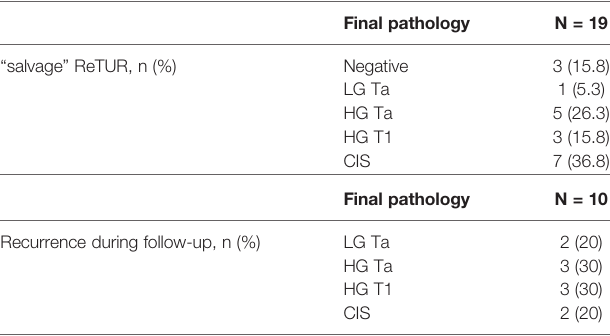
TABLE 3 | Histopathology result at ReTUR for the 19 patients who underwent a second resection because of either positive UC or cystoscopy and for the 10 patients who had recurrence during the follow-up.